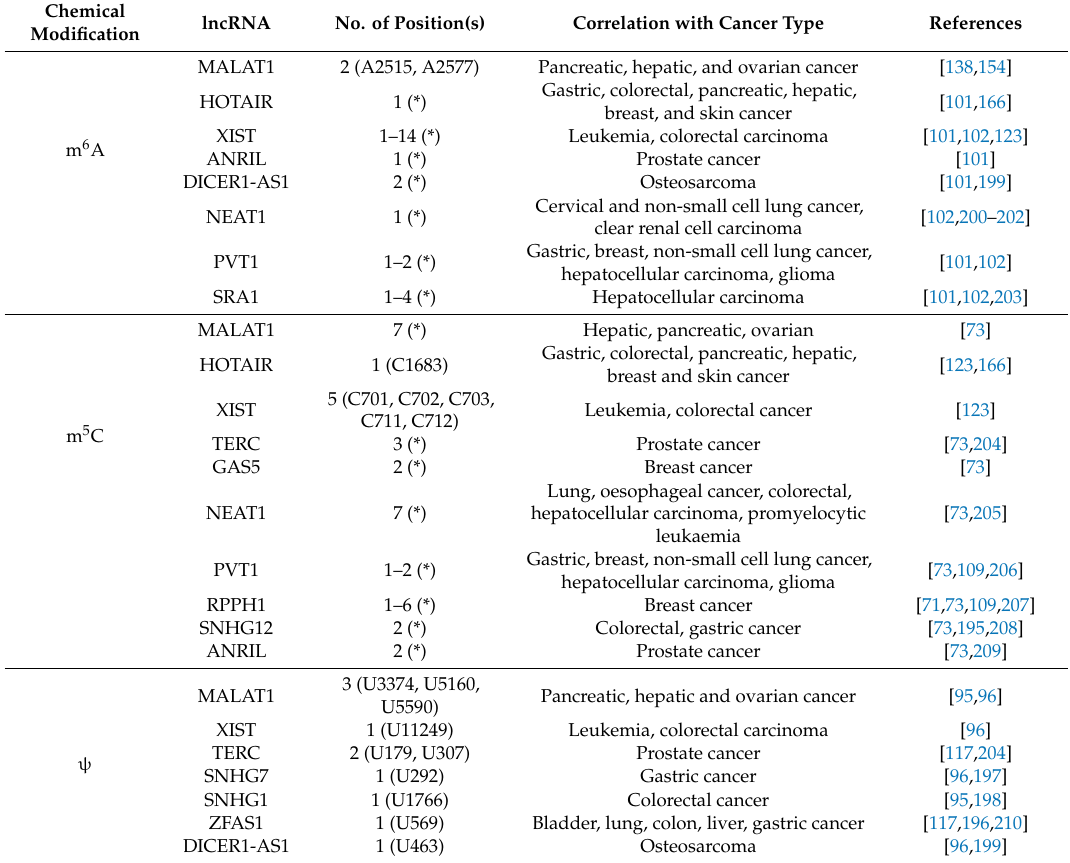
Table 2. Chemical modifications found in lncRNAs and their possible involvement in di ff erent types of cancer. *Number of the positions of RNA modifications varies between studies. MALAT1: metastasis associated lung adenocarcinoma transcript 1; HOTAIR: HOX antisense intergenic RNA; XIST: X-inactive specific transcript; ANRIL: antisense non-coding RNA in the INK4 locus; DICER-AS1: DICER1 Antisense RNA 1; NEAT1: nuclear-enriched abundant transcript 2; PVT1: Pvt1 oncogene non-protein coding; SRA1: Steroid Receptor RNA Activator 1; TERC: telomerase RNA component; GAS5: growth arrest-specific transcript 5; RPPH1: ribonuclease P RNA component H1; SNHG: Small nucleolar RNA host gene; ZFAS1: Zinc finger antisense